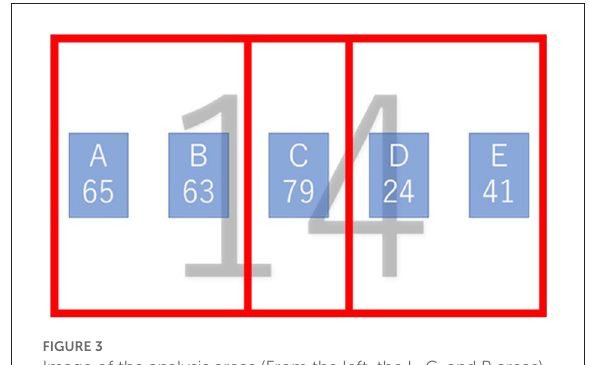
FIGURE3 Image of the analysis areas (From the left, the L, C, and R